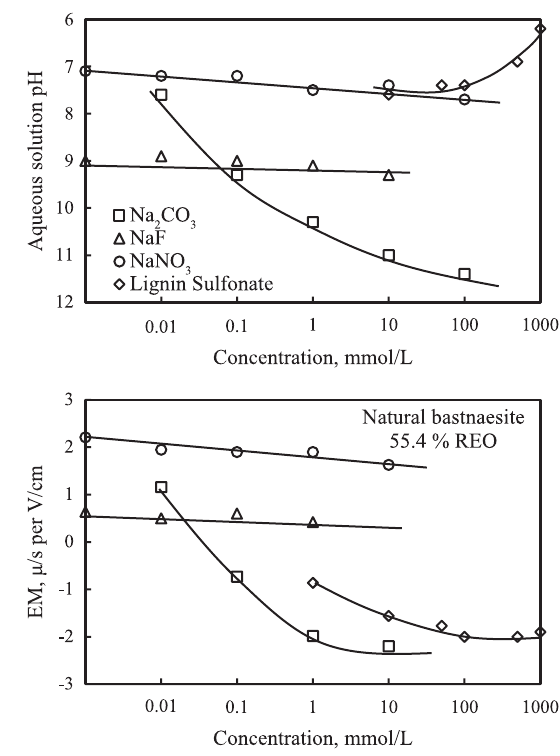
Fig. 7 Electrophoretic mobility of natural bastnaesite as a function of concentration (bottom) and the correspond - ing aqueous solution pH (top) in the presence of sodium nitrate, sodium carbonate, sodium fluoride and ammo - nium lignin sulfonate solutions, respectively